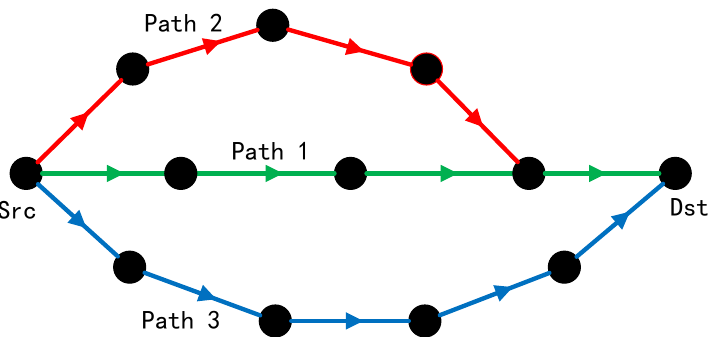
Figure 2. Example of paths overlapping of multipath transmission.